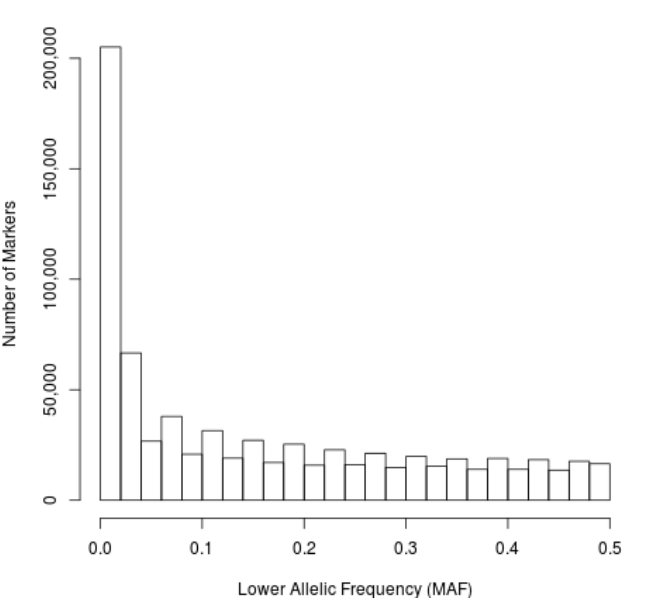
Figure 3. Allelic frequency among the autosomal markers of Indubrasil animals.